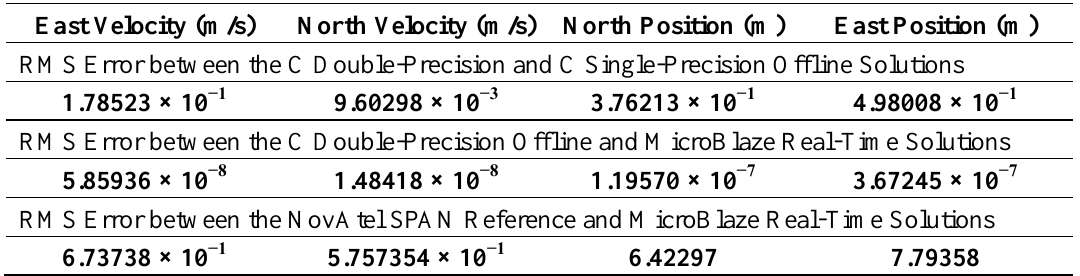
Table 7. RMS Error in the East Velocity, North Velocity, North and East Positions over Land Vehicle Trajectory (1).